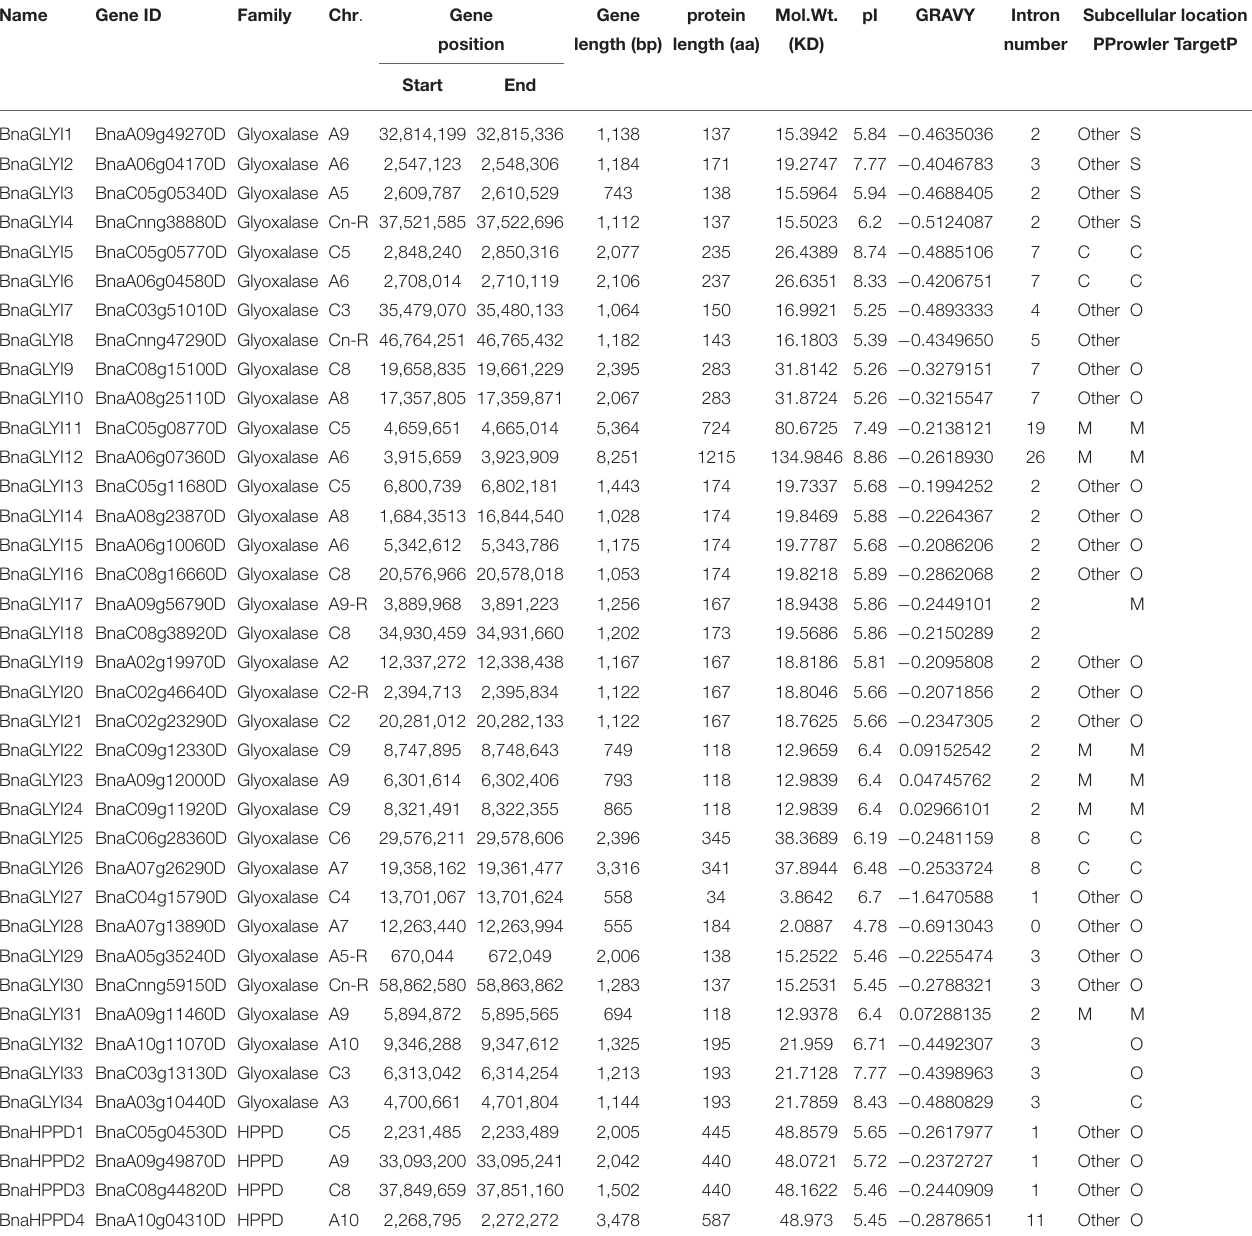
TABLE 1 | VOC genes in B. napus genome and their sequence characteristics and subcellular location